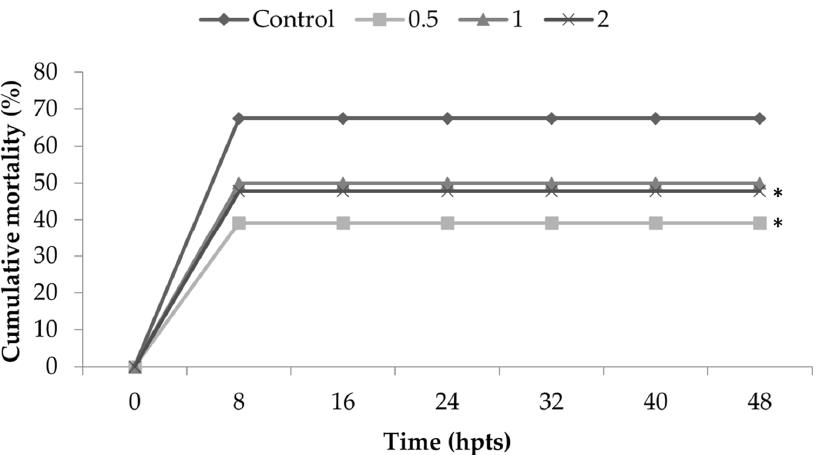
Figure 2. Cumulative mortality of Litopenaeus vannamei fed for 15 days with diets containing 0.5, 1 and 2% of Nannochloropsis spp. and control diet (0% inclusion). Shrimp were observed for 48 h post-thermal shock (hpts). Statistical differences among the treatments were observed ( p = 0.03633). In comparison with the control (0%), the statistical differences were as follows: 0.5% group ( p = 0.00446) and 2% group ( p = 0.03898). The group fed 1% presented no statistical difference ( p = 0.06412). * corresponds to statistical difference in comparison to control.